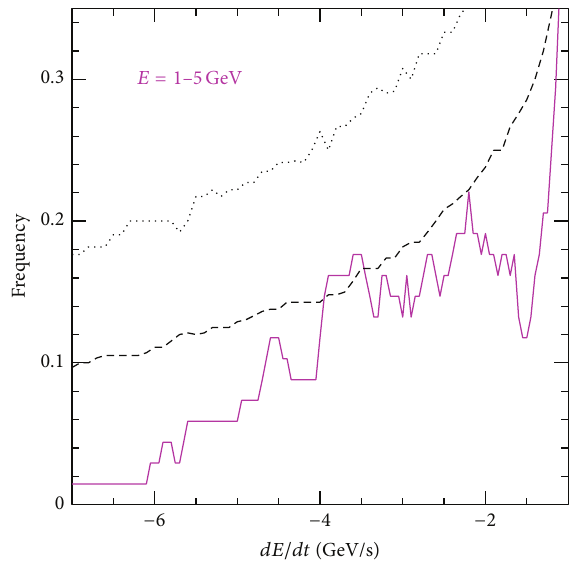
Figure 6: Here shown are the results of a study of the type already described in Figure 5, but now restricting the analysis to photons with energy between 1GeV and 5 GeV. Again the dotted line and the dashed line estimate, respectively, the 1 % and 10 % probability that the given frequency of occurrence of spectral lags is a chance